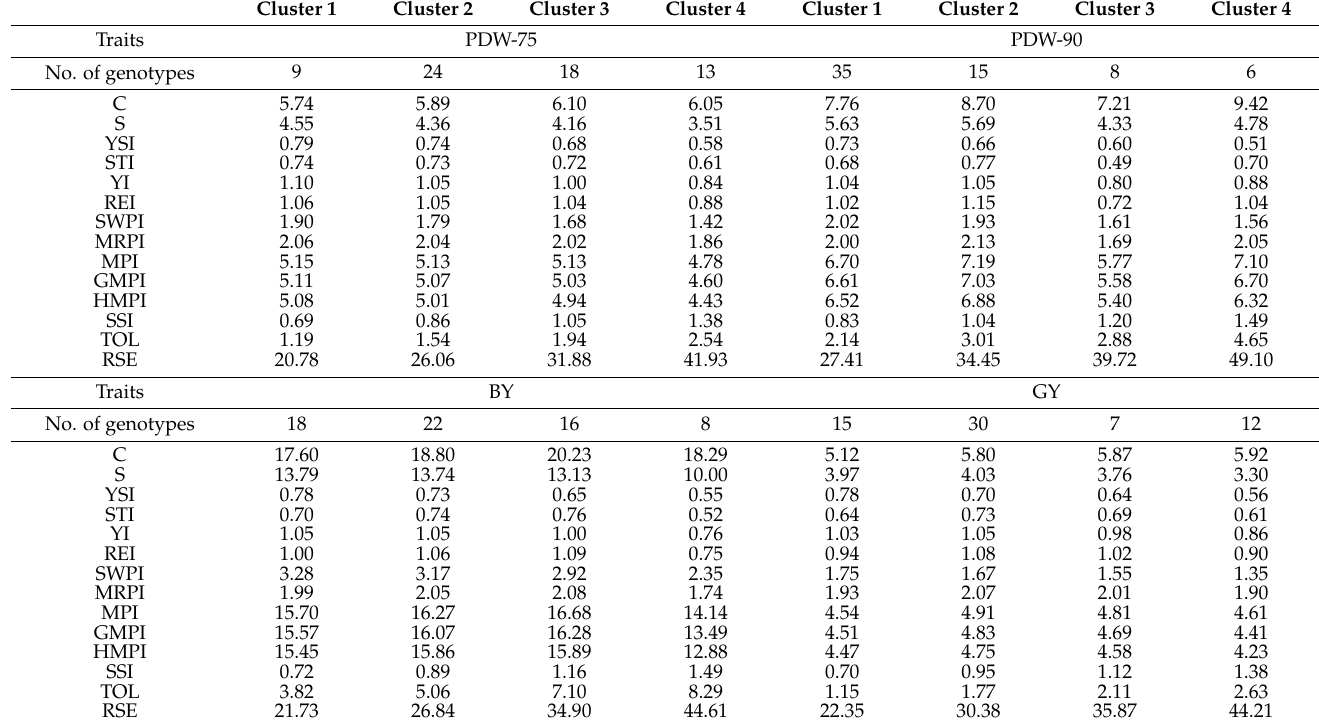
Table 6. Comparison profile of the four clusters of 64 wheat genotypes classified by robust hierarchical clustering (cluster figures are means of plant dry weight measured at 75 (PDW-75) and 90 (PDW-90) days after sowing, biological yield (BY), grain yield (GY) under the control (C) and salinity (S) conditions and their different stress tolerance values for the genotypes in each